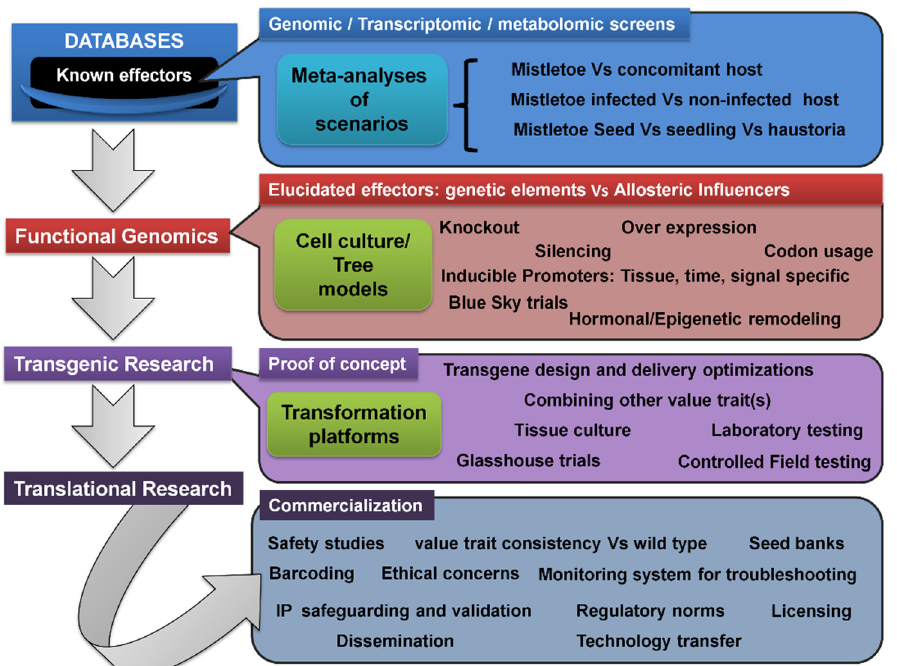
Figure 5. Generalized transgenic and translational research pipeline for developing and disseminating stable mistletoe-resistant tree hosts of commercial value(s). Genetic elements (or their homologs) putatively conferring mistletoe resistance may be recovered from relevant repositories such as the NCBI’s GenBank and KEGG, and also may be screened using systems biology and bioinformatics tools, following genomic, transcriptomic, and metabolomic analyses. Some suggestions are depicted in Figure 4. Precisely, such meta-analyses can be performed on various pairs of genetic/expression pools. Once the genetic elements directly encoding the resistance trait or indirectly influencing the parasitism are stipulated, they may be tested on various grounds in small-scale assays and observa- tions, in order to plan the appropriate design of the transgenic framework. In this way, cell and tissue culture models of parasitism involving trees and mistletoes may be indispensable and may generate proof(s) of concept(s). Then, a focused transgenic gene manipulation and characterization stage would involve lab-to-field-scale testing and validation of the successfully developed events.